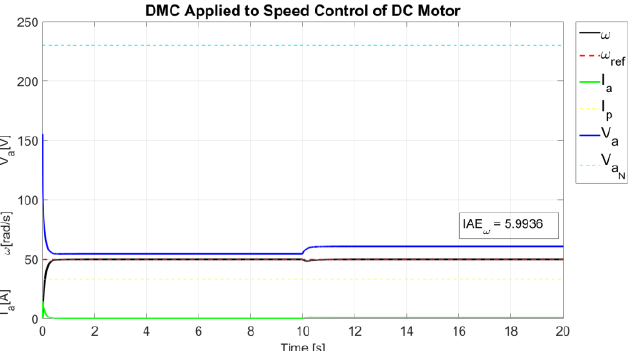
Fig. 6 present values of speed, armature current and